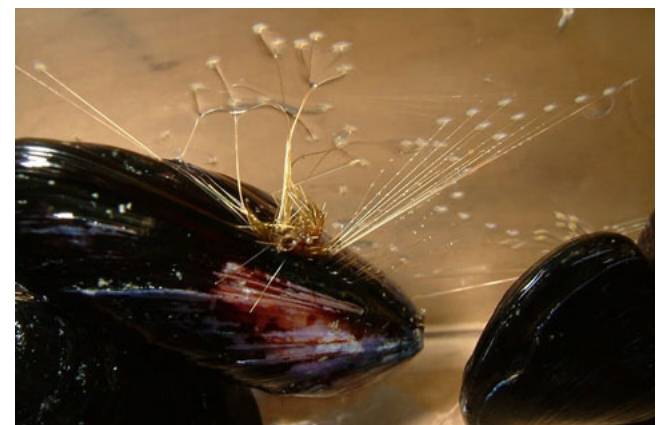
Fig. 2 Fixation by the